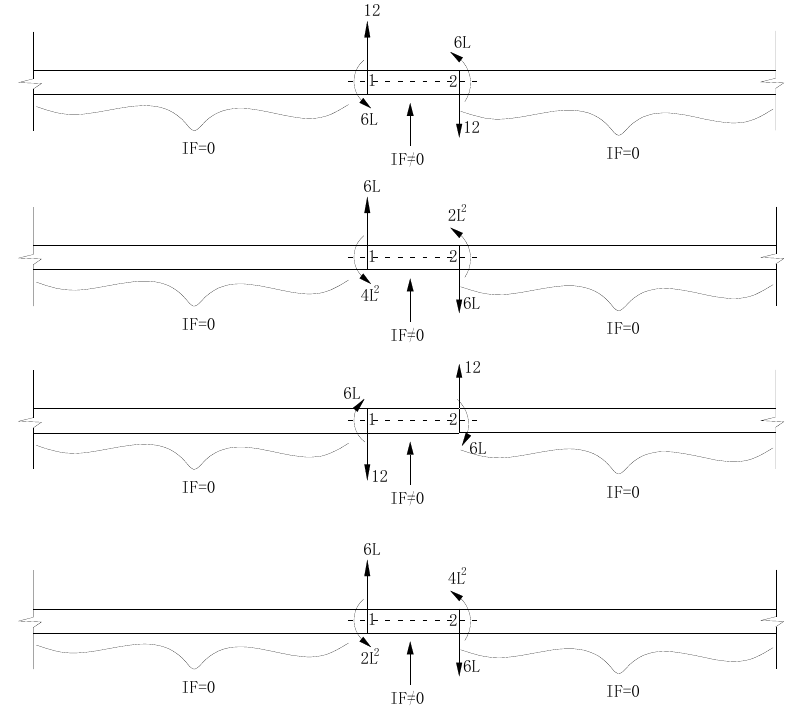
Figure 3. The internal force (IF) distributions of the structure under characteristic forces.